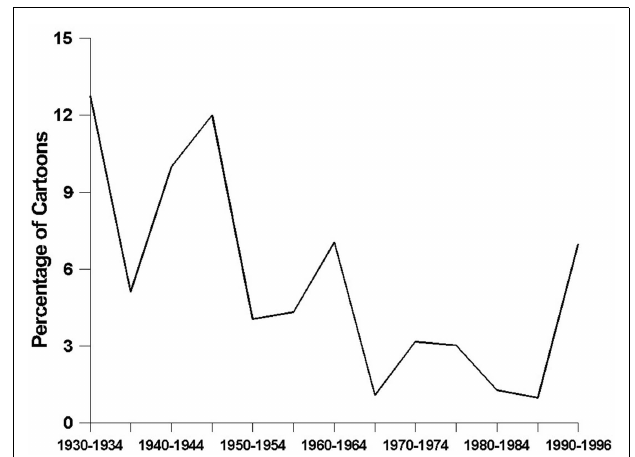
FIGURE 1 |The prevalence of alcohol-related depictions.